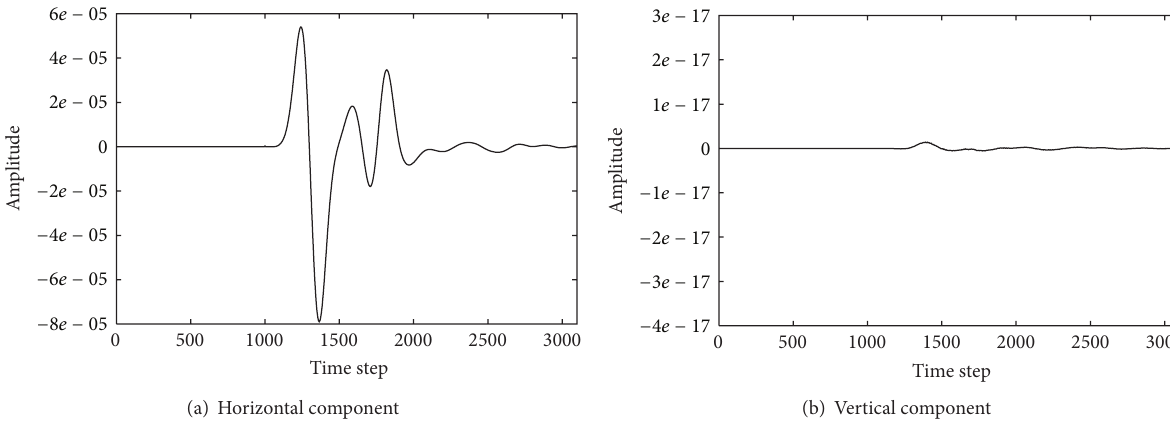
Figure 8: Displacement observed at the point (−0.3, 0.5) .